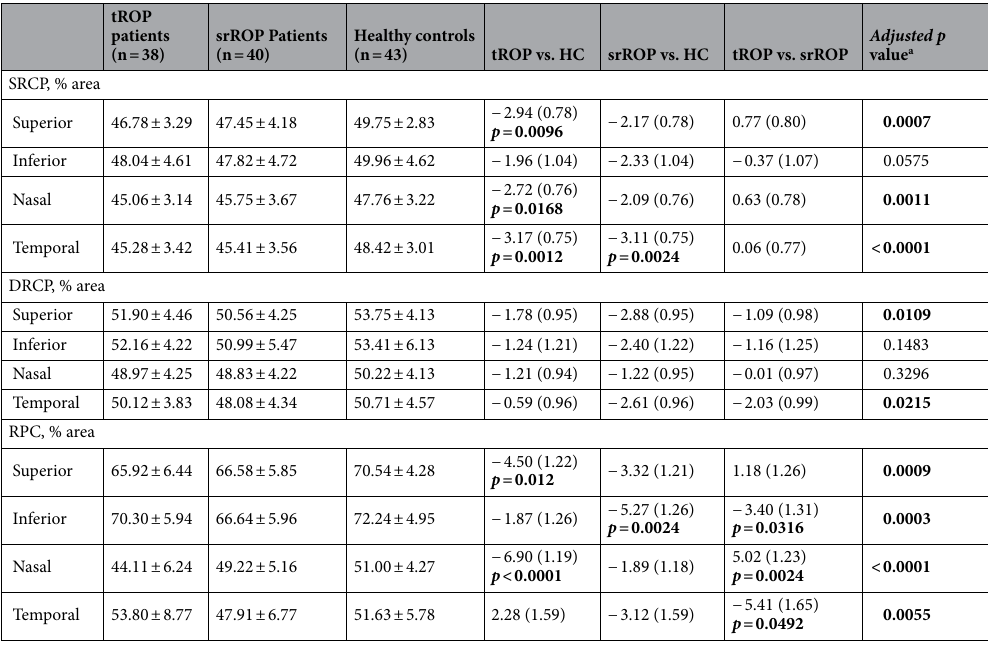
Table 4. Comparison sectored vessel densities of the superficial, deep retinal capillary plexus and radial peripapillary capillary segment between preterm patients with a history of retinopathy of prematurity with treatment, spontaneously regressed, and full-term healthy controls. tROP, retinopathy of prematurity with laser treatment; srROP, spontaneously regressed retinopathy of prematurity; HC, healthy controls; FAZ, foveal avascular zone; SRCP, superficial retinal capillary plexus; DRCP, deep retinal capillary plexus; RPC, radial peripapillary capillary; SE, standard error; CI, confidence interval. Values are shown as mean ± standard deviation. a p value was calculated by multivariate linear regression with adjustment for age and Bonferroni correction multiplied by 3. In each group comparison, Bonferroni correction was performed by multiplying p value by 12 due to multiple testing of outcomes. Boldface indicates statistical